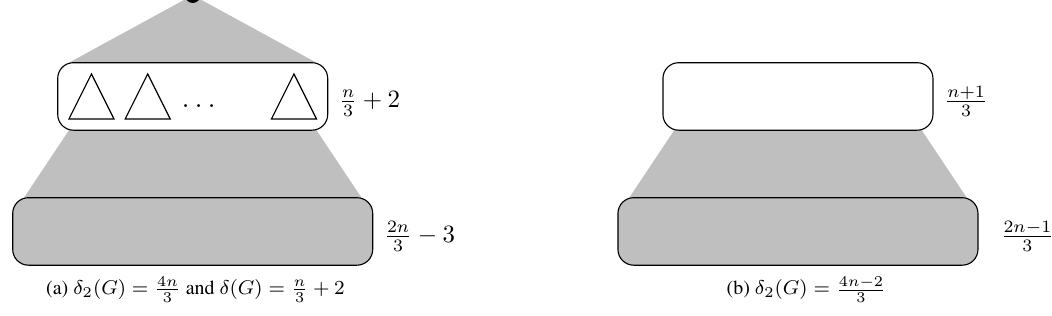
Fig. 1: Examples showing the tightness of the degree conditions in Theorem